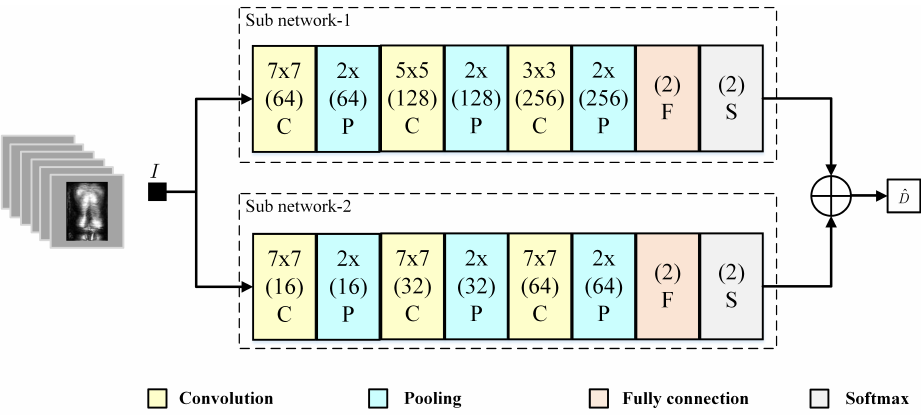
Figure 4. Structure of the clutter anomaly detector. Two different convolution structure are used for extracting the fine textures and the contour information of the body clutter